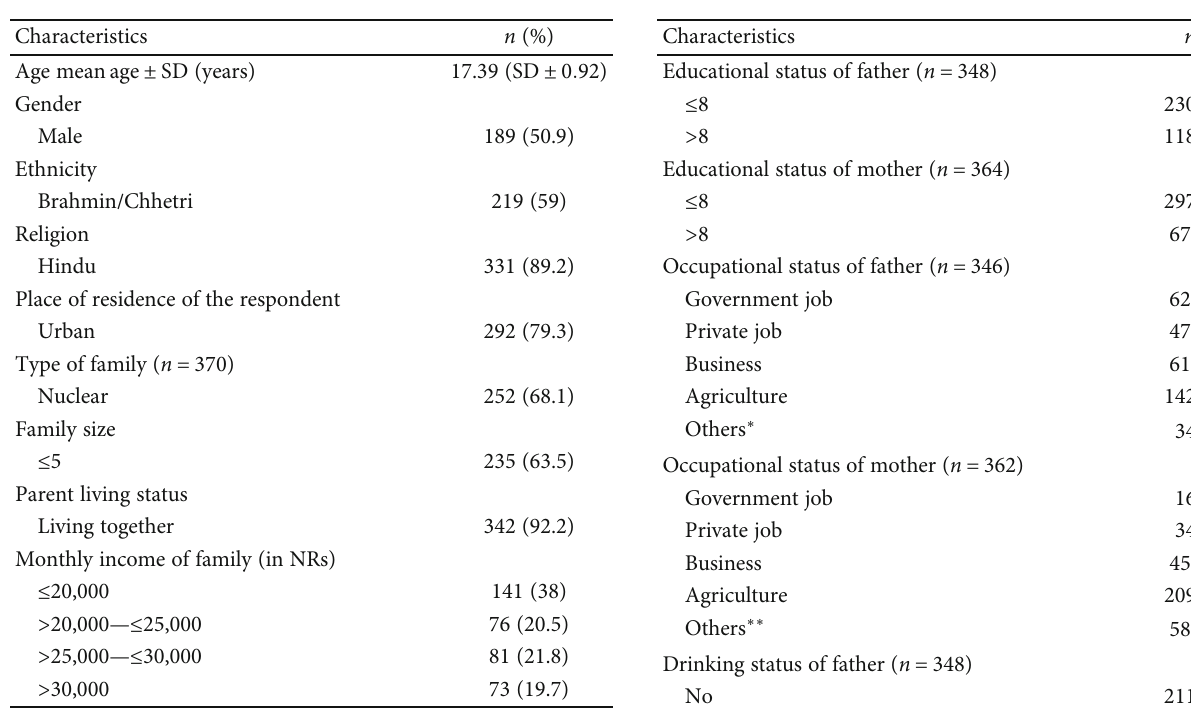
Table 1: Demographic and economic characteristics of respondents ( n = 371 ).